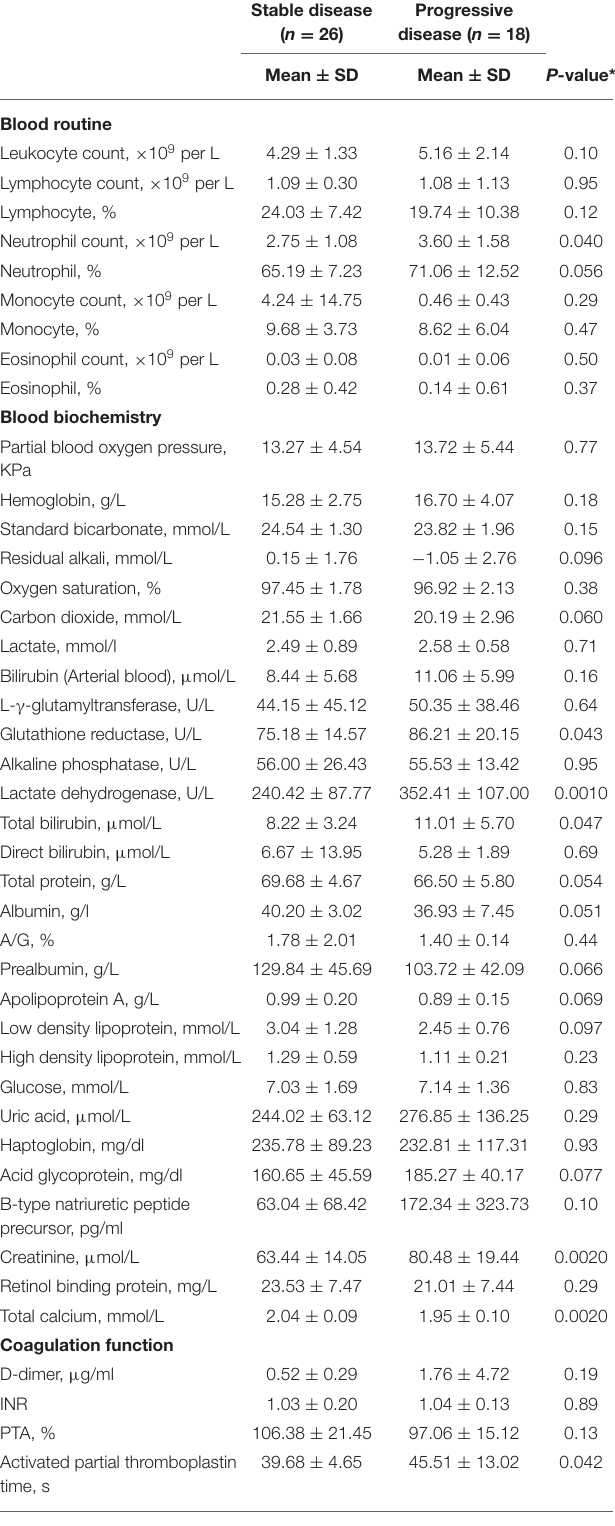
Stable disease Progressive ( n = 26) disease ( n = 18) Mean ± SD Mean ± SD P-